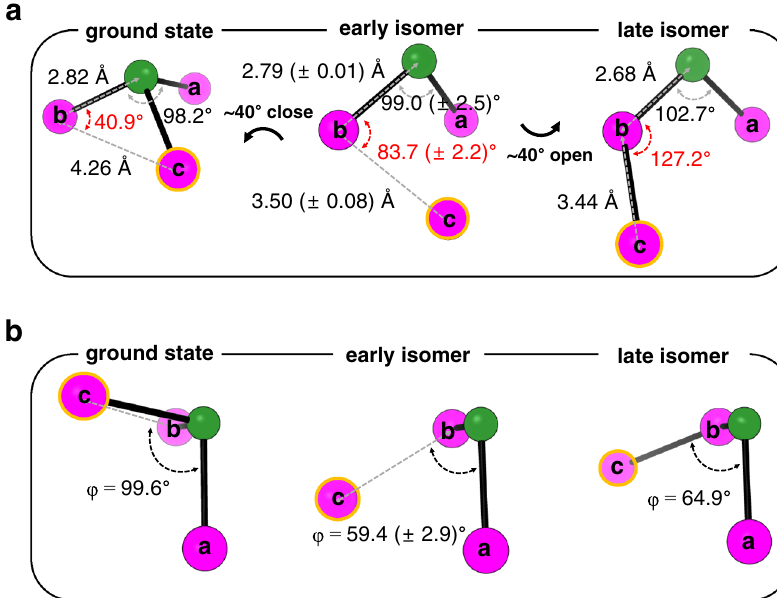
Fig. 4 The optimized structure of the early isomer. a Side views and b top views of the structure of the early isomer optimized in the global fi t analysis (middle) in comparison with the structures of the ground-state BiI 3 (left) and late isomer (right). Green and magenta spheres stand for Bi and I atoms, respectively, and three I atoms are labeled with a, b, and c. Among the three I atoms, I c is highlighted with an orange circle for a more clear comparison of the structures. Side views of the molecules are shown to visualize the overall structures, while top views of the molecules are shown to represent the dihedral angles. The early isomer has the structure that can switch to either the ground-state or the late isomer of BiI 3 mainly by closing or opening of its Bi-I b -I c angle by ~40°. The error values in parentheses correspond to one standard-deviation of each structural parameter used in the global fi t